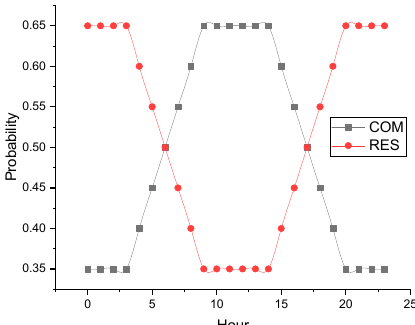
Figure 1. The probability for a commercial or residential EVCS to be chosen by an EV that needs to be charged during the day. The COM EVCS’s probability is divided randomly between the 15 stations around their average, while the RES EVCS’s probability is divided randomly between the 12 stations around their average.